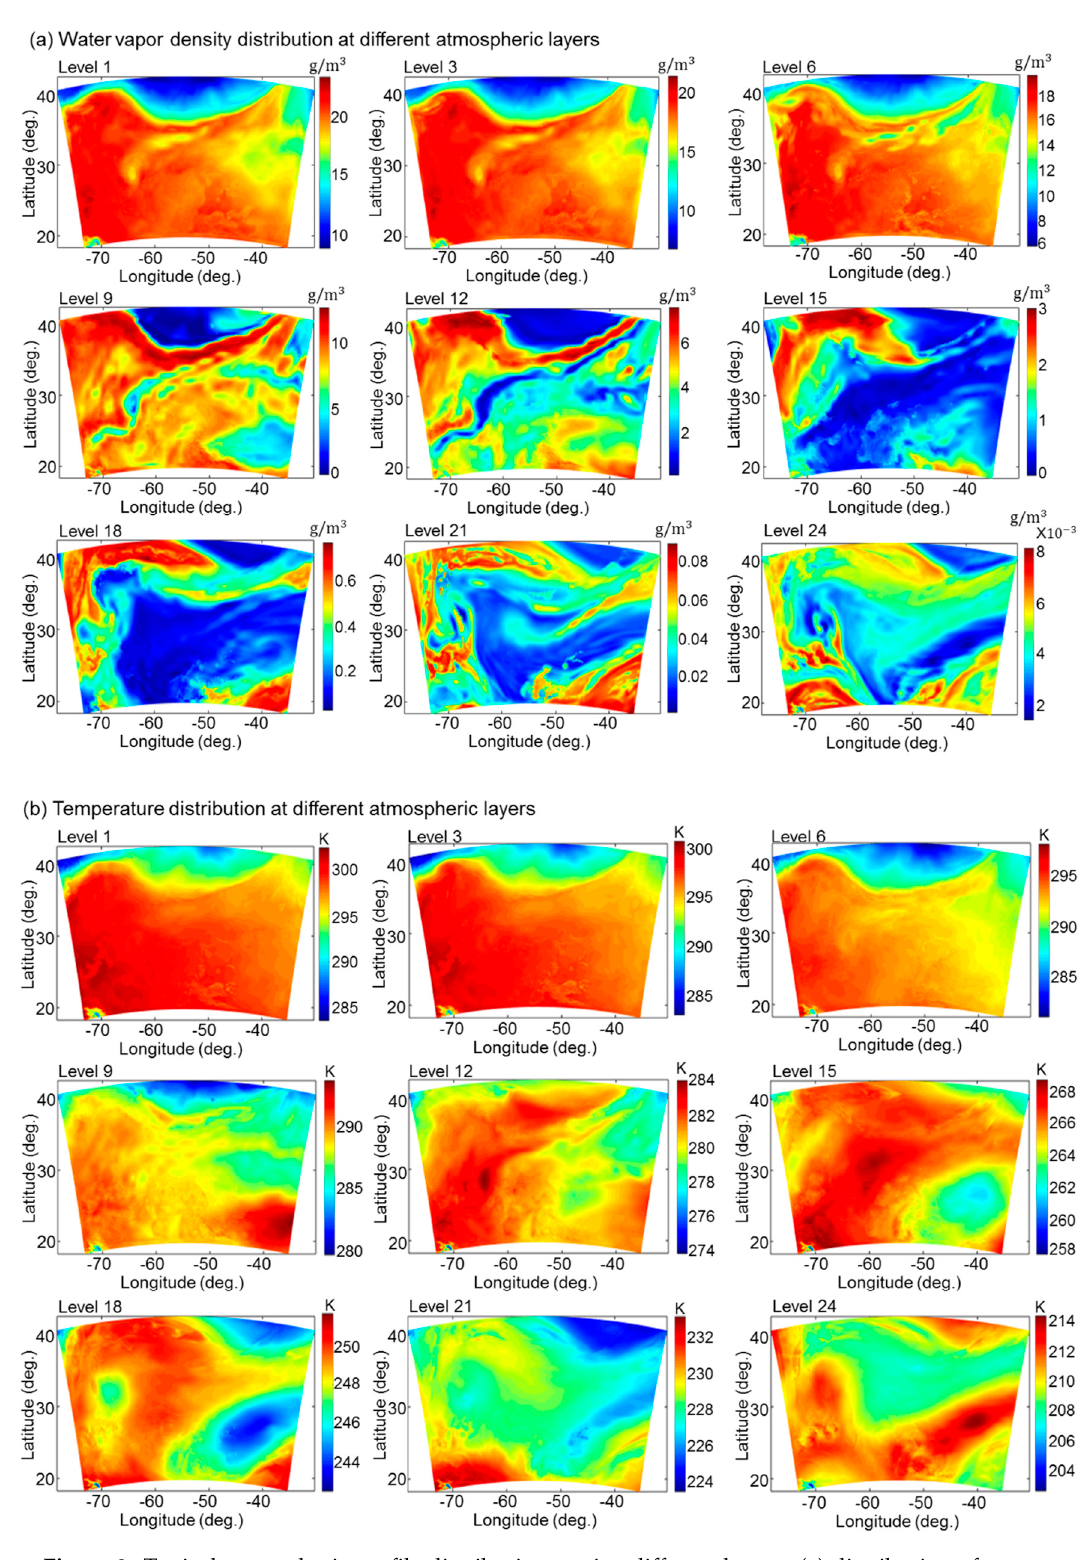
Figure 9. Typical atmospheric profile distribution at nine different layers: ( a ) distribution of water vapor density; and ( b ) distribution of temperature. The pressures at different levels are: Level 1, 1004 mb; Level 3, 985 mb, level 6, 932.15 mb, Level 9, 831.3 mb; Level 12, 693.8 mb; Level 15, 504.4 mb; Level 18, 358.4 mb; Level 21, 248.1 mb; and Level 24, 166.2 mb.